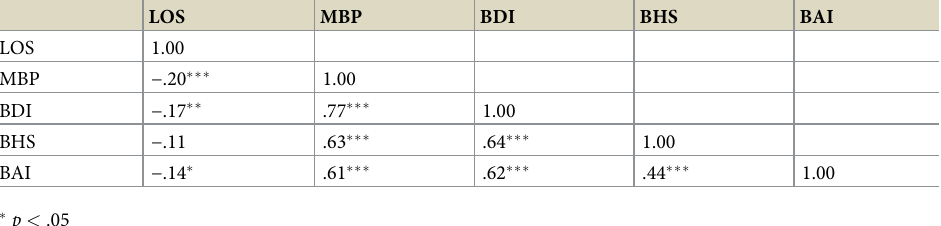
Table 3. Correlations among the Mee-Bunney Psychological Pain Assessment Scale (MBP), Beck Depression Inventory (BDI), Beck Hopelessness Scale (BHS), Beck Anxiety Inventory (BAI) and treatment program Length of Stay